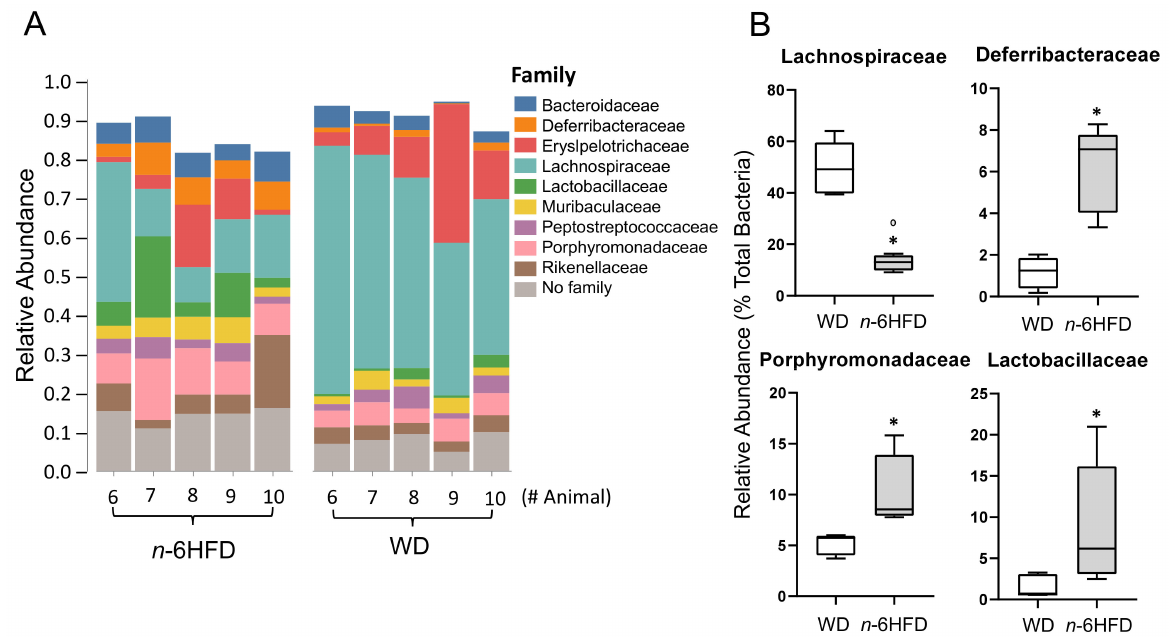
Figure 10. Family relative abundances of bacteria in cecal samples of C57BL/J6 male mice at 16 weeks of age. ( A ) Columns represent individual mice fed the WD or n -6HFD with bars capturing the relative percent bacterial family abundance (% of total). ( B ) Box and whisker plots of relative percent abundances (% of total) in cecal samples of WD and n -6HFD-fed mice at 16 weeks of age for Lachnospiraceae, Deferribacteraceae, Porphyromonadaceae, and Lactobacillaceae. Data were analyzed utilizing the Mann–Whitney U test. Medians with an asterisk (*) differ, p <